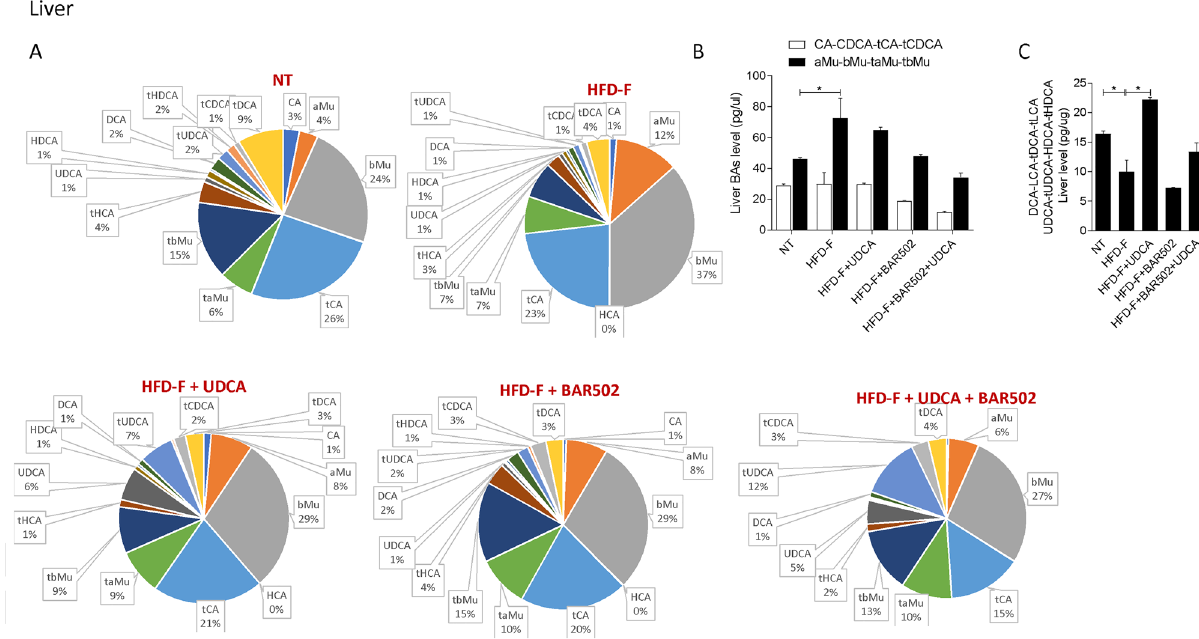
Figure 9. ( A ) Composition of liver bile acid pools. ( B ) Fxr agonist and antagonist bile acids content in liver. ( C ) Concentration of Gpbar1 agonist bile acids. Each result is the mean ± SEM of 7–11 mice per group. *p ≤